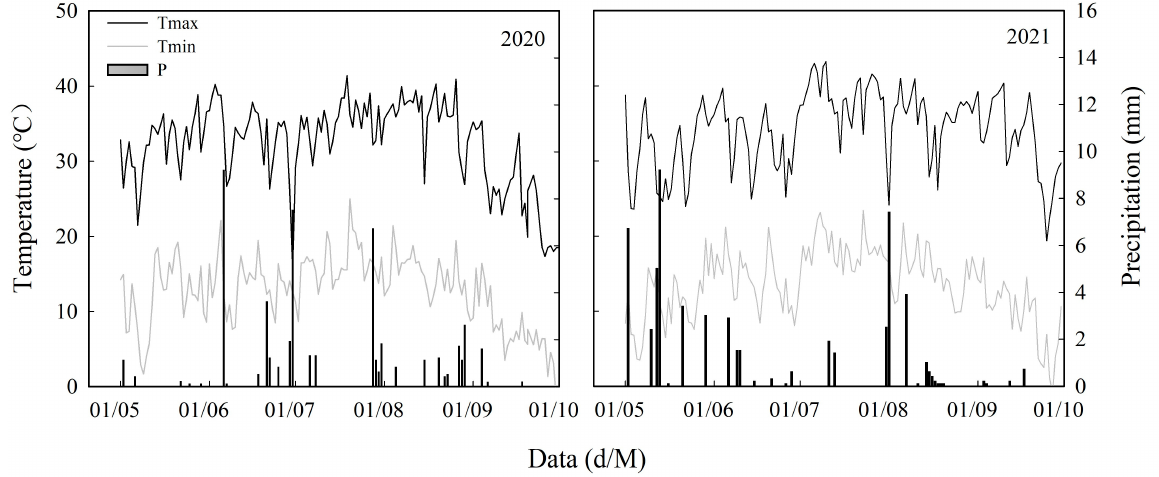
Figure 1. Maximum temperature (T max), minimum temperature (T min) and rainfall (P) during rice growth period (2020 − 2021).